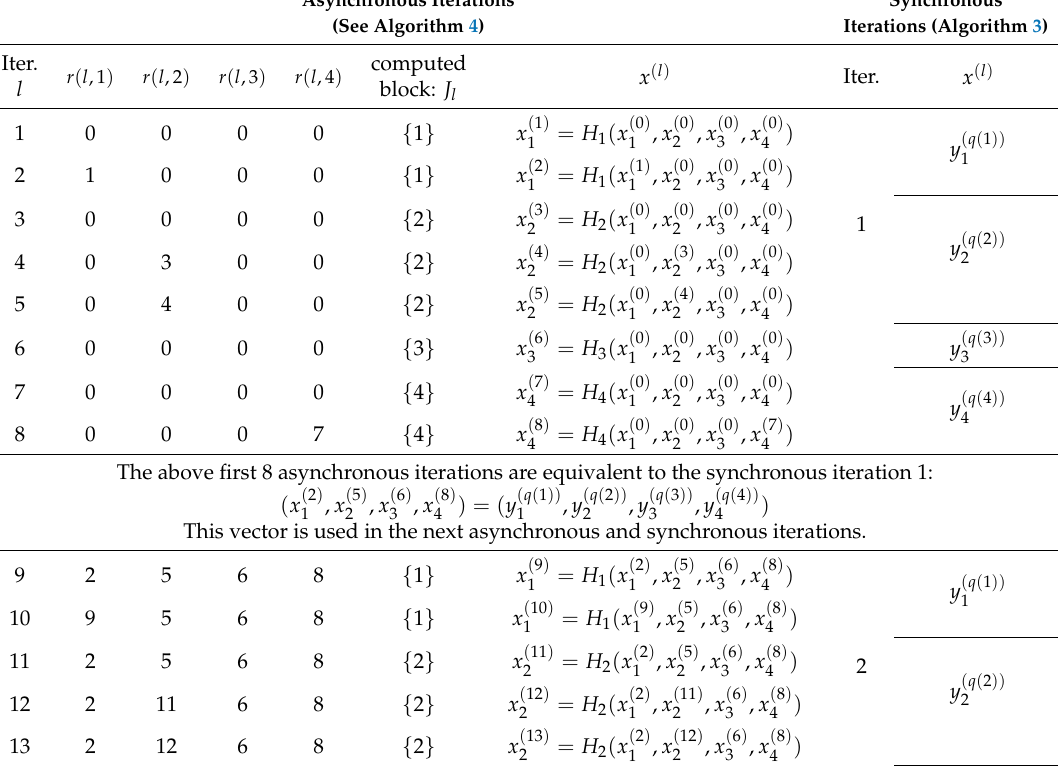
Table 1. Example of equivalence between non-stationary synchronous and asynchronous iterations, p = 4 and ( q ( 1 ) , q ( 2 ) , q ( 3 ) , q ( 4 )) = ( 2,3,1,2 ) . Asynchronous Iterations Synchronous (See Algorithm 4) Iterations (Algorithm 3)